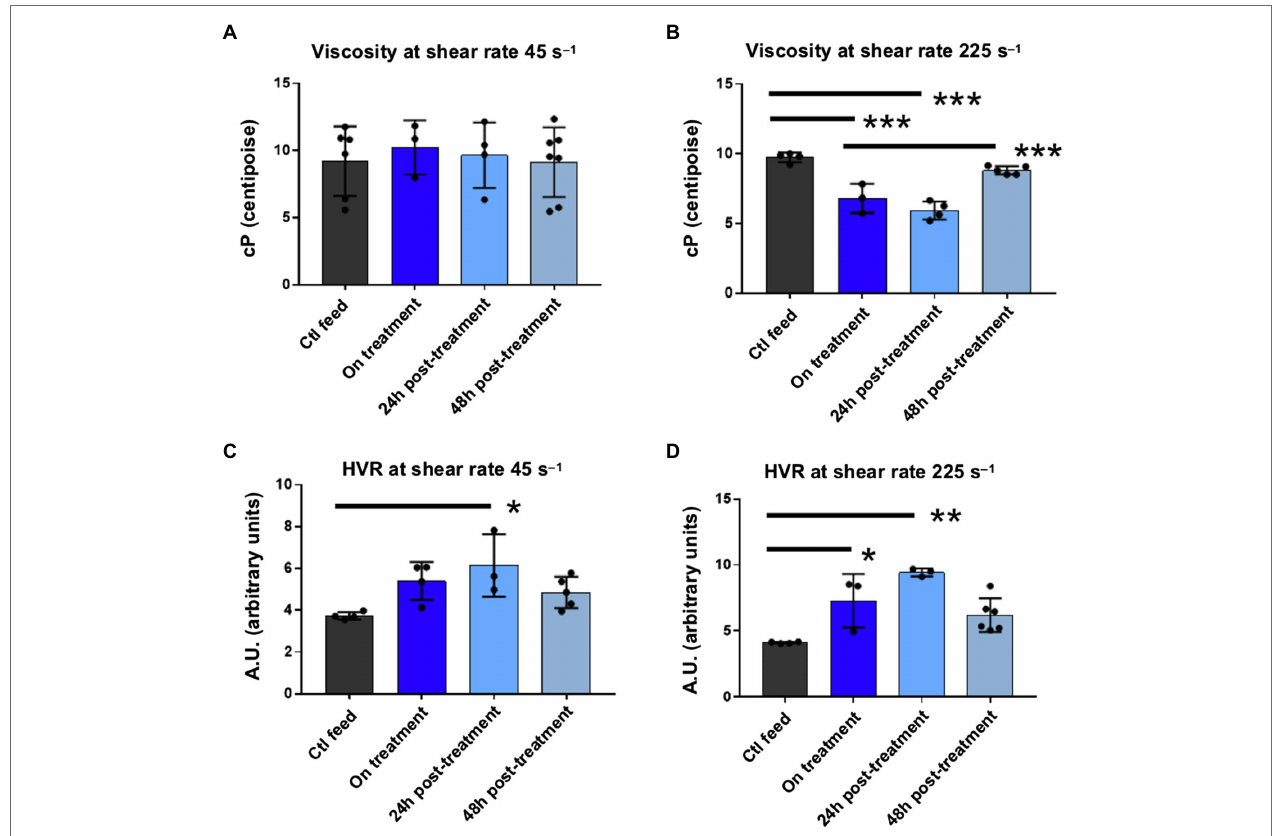
FIGURE 2 | Viscosity and HVR measurements on and off GBT1118. (A) At a shear of 45 s − 1 , modeling in viscosity from baseline. Ctl n = 6, on treatment n = 3, 24 h post n = 4, and 48 h post n = 7. (B) At a shear of 225 s − 1 , modeling arterial circulation, viscosity on drug declines from baseline on treatment, and 24 h off drug. There is no significant rise in viscosity 48 h off drug compared to baseline. Ctl n = 4, on treatment n = 3, 24 h post n = 4, and 48 h post n = 5. (C) At an HVR at 45 s − 1 , oxygen carrying increased 24 h off drug. Ctl n = 4, on treatment n = 4, 24 h post n = 3, and 48 h post n = 5. (D) At an HVR at 225 s − 1 , oxygen carrying capacity increased on drug and 24 h off drug. There was no significant decline in HVR 48 h off drug compared to baseline at 225 s − 1 or 45 s − 1 HVR. Ctl n = 4, on treatment n = 3, 24 h post n = 3, and 48 h post n = 6. *** p < 0.0001; ** p < 0.0051; and * p < 0.05. HVR, hematocrit-to-viscosity